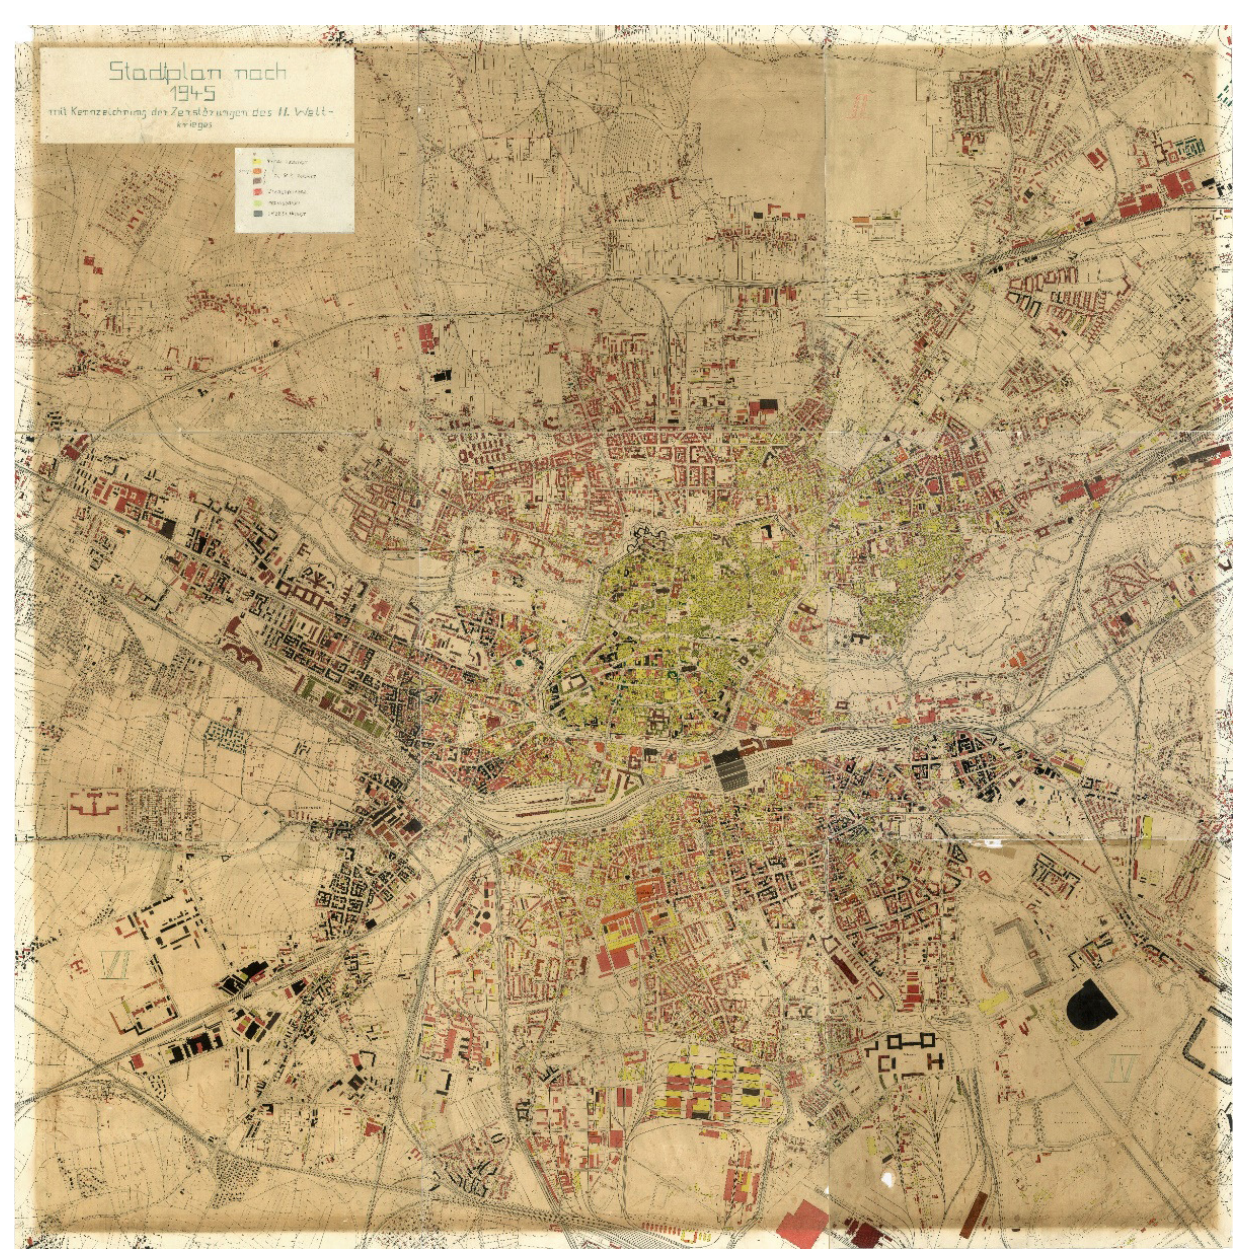
Figure 1. Damage map of Nuremberg (1950) drawn on a base map from 1945. Source: “Stadtplan nach 1945 mit Kennzeichnung der Zerstörungen des II Weltkrieges”